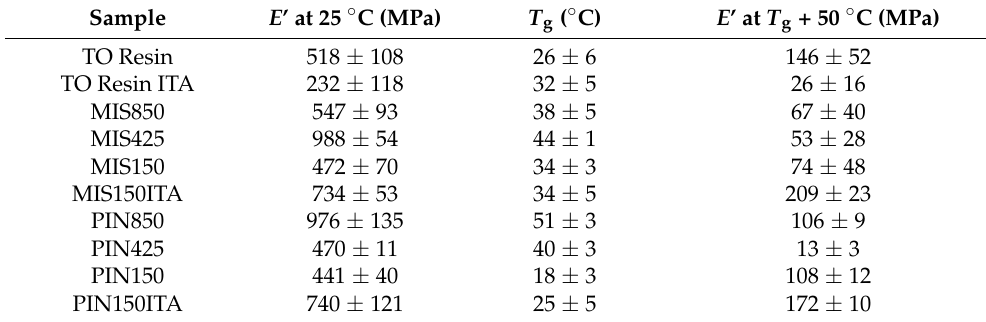
Table 3. DMA results for the unreinforced resin with and without ITA, and for miscanthus and southern pine composites prepared with different particle sizes and with and without